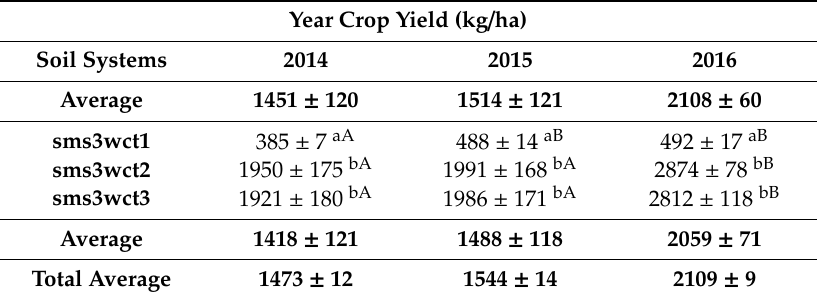
Table A3. Total isoflavone concentration in soybeans for 2014–2016, three soil systems . Different lowercase letters indicate significant differences between the means of the soil tillage systems in the same year, while capital letters indicate significant differences between the means of different years but the same soil tillage systems according to Tukey’s HSD test ( P ≤ 0.05).